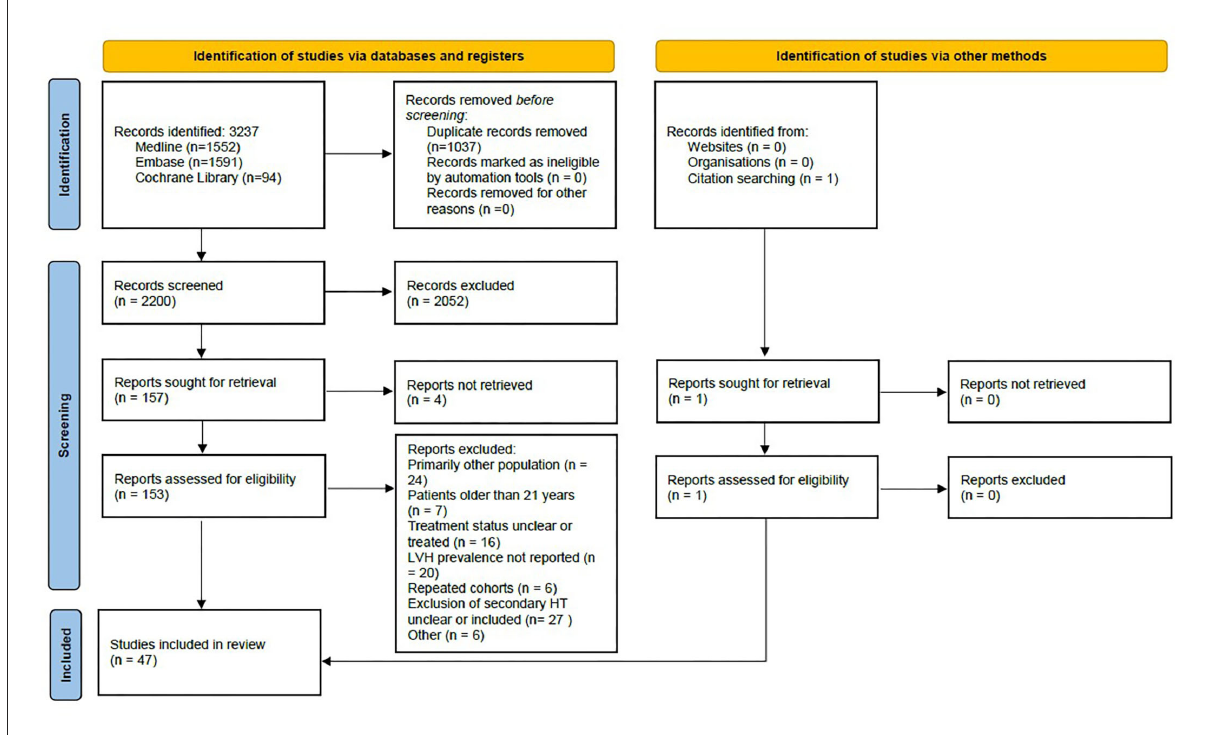
FIGURE1 PRISMA flow diagram for article